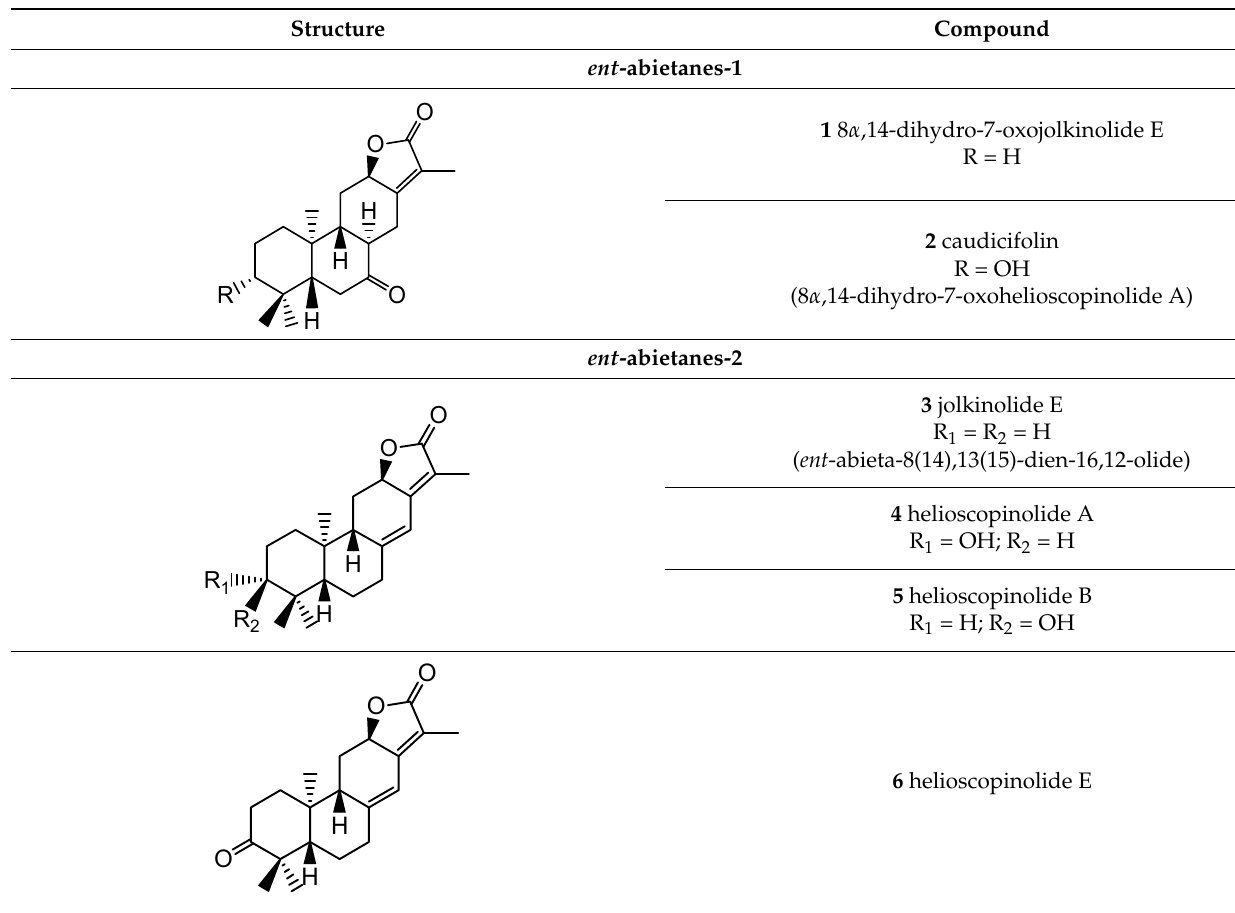
Table 1. Diterpenoids identified from aerial parts (leaves and stems) (compounds 1 – 10 , 12 – 14 ) [12] and latex (compounds 11 , 15 ) [18] of E. characias : structure of ent- abietanes, ent -atisanes, ent- kauranes, ent -pimaranes and cembrene.